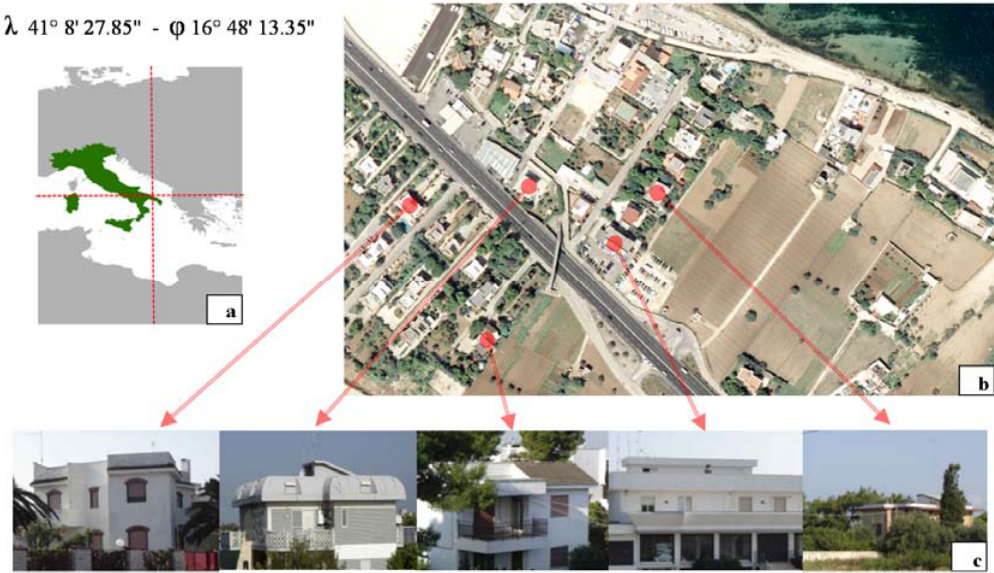
Figure 1. (a) Localization of the study area, (b) the sub-set data overlapping two stereo image data, and (c) the investigated mixed housing typology.